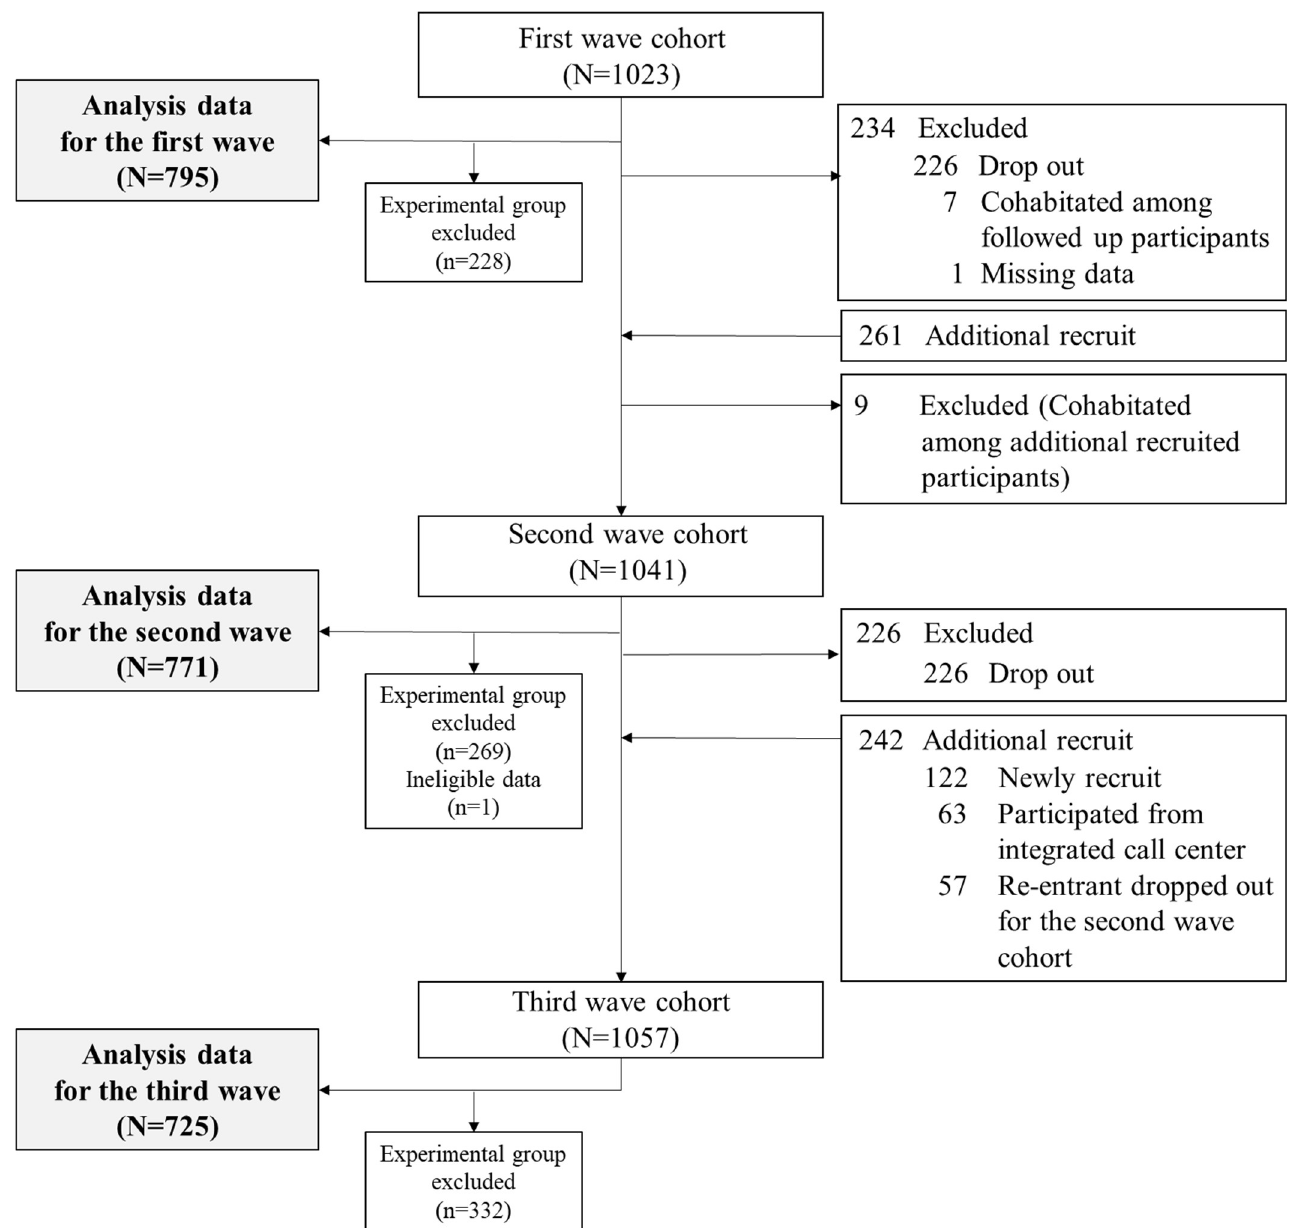
Fig 1. Flow chart for the process of cohort and